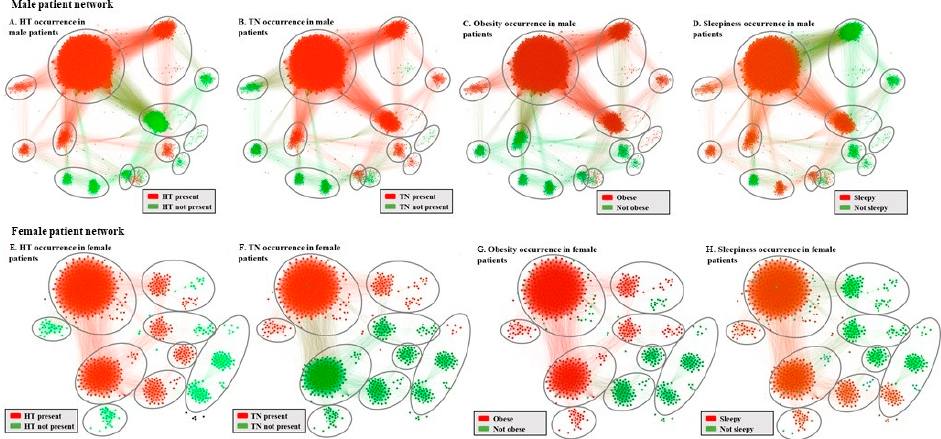
Figure 2. Mapping of obstructive sleep apnea syndrome(OSAS) parameter classes on the MPN and FPN, where ellipses mark each of the eight defined phenotypes, for identifying: ( A , E ) Hypertension (HT) presence; ( B , F ) Thick neck (TN) presence; ( C , G ) Obesity presence; ( D , H ) Daytime sleepiness presence in males/females.